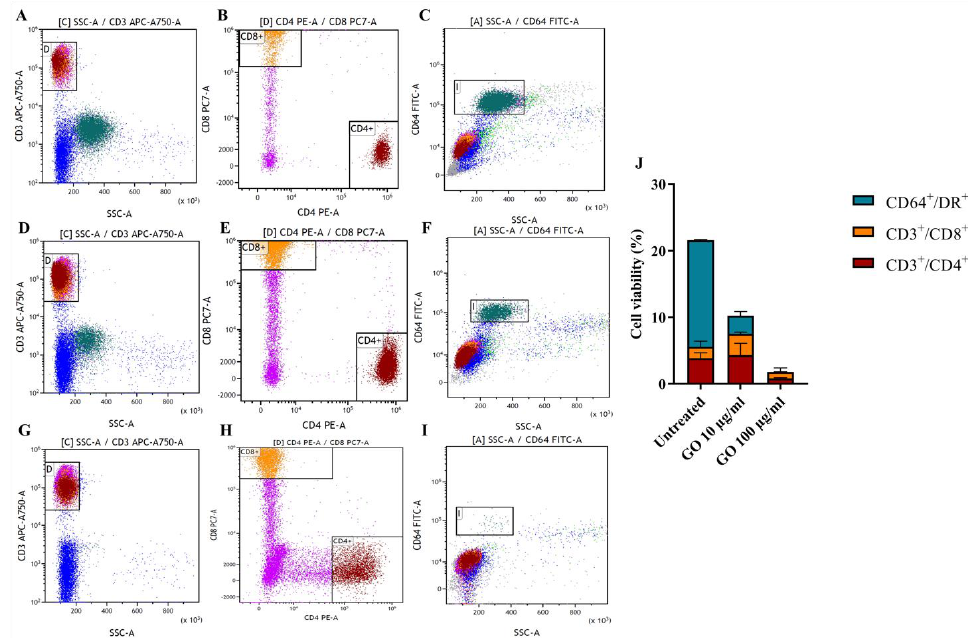
Figure 4. Viability assessment of hPBMC subpopulations after GO treatment. Single lymphocyte populations (CD3+/CD8+ and CD3/CD4+) and monocyte populations (CD64+) were evaluated among untreated cells ( A – C ) and following incubation for 1 h, with GO at the final concentrations of 10 µg/mL ( D – F ) and 100 µg/mL ( G – I ). Lymphocyte viability was evaluated through CD3 APC-